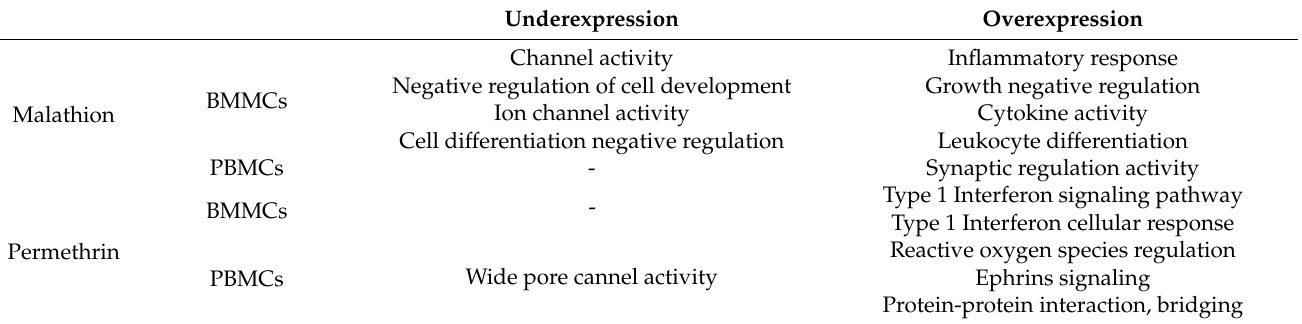
Figure 11. GeneMANIA tool interaction analysis of overexpressed genes in BMMCs exposed to malathion. Table 5. GeneMANIA analyses of the 100 genes with the highest overexpression and the 100 with the lowest under expression. ( ‐ ) No results were obtained.